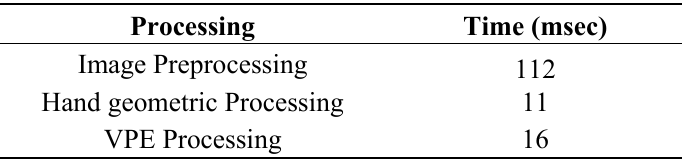
Table 4. The computational timing for